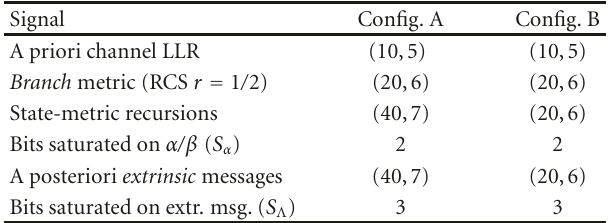
Figure 13: Analysis of the performance of the fixed-point turbo- decoding algorithm. Table 2: Optimal fixed-point parameters of the turbo